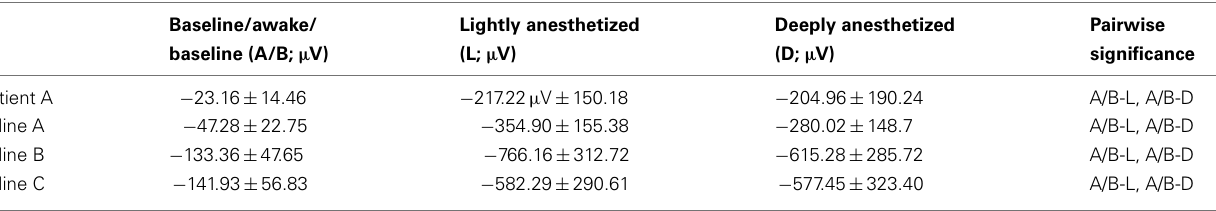
Table 3 |The average minimum across all electrodes ( N = 96) for theAP-aligned LFP analysis (mean ± SD). Baseline/awake/ Lightly anesthetized baseline (A/B; µ V)